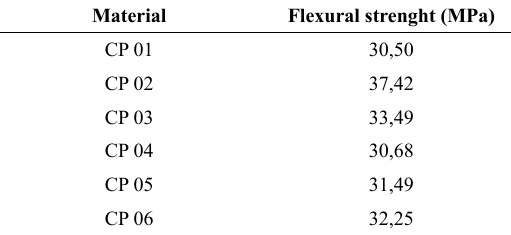
Table 1. Flexural strength values for the artificial marble